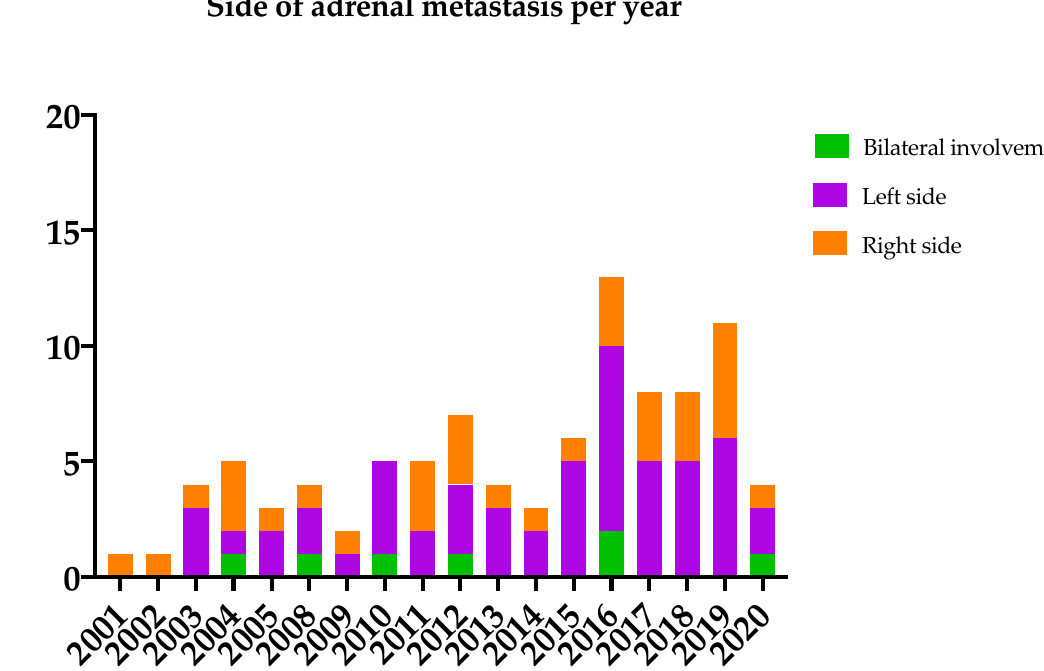
Figure 1. Location of adrenal metastasis.